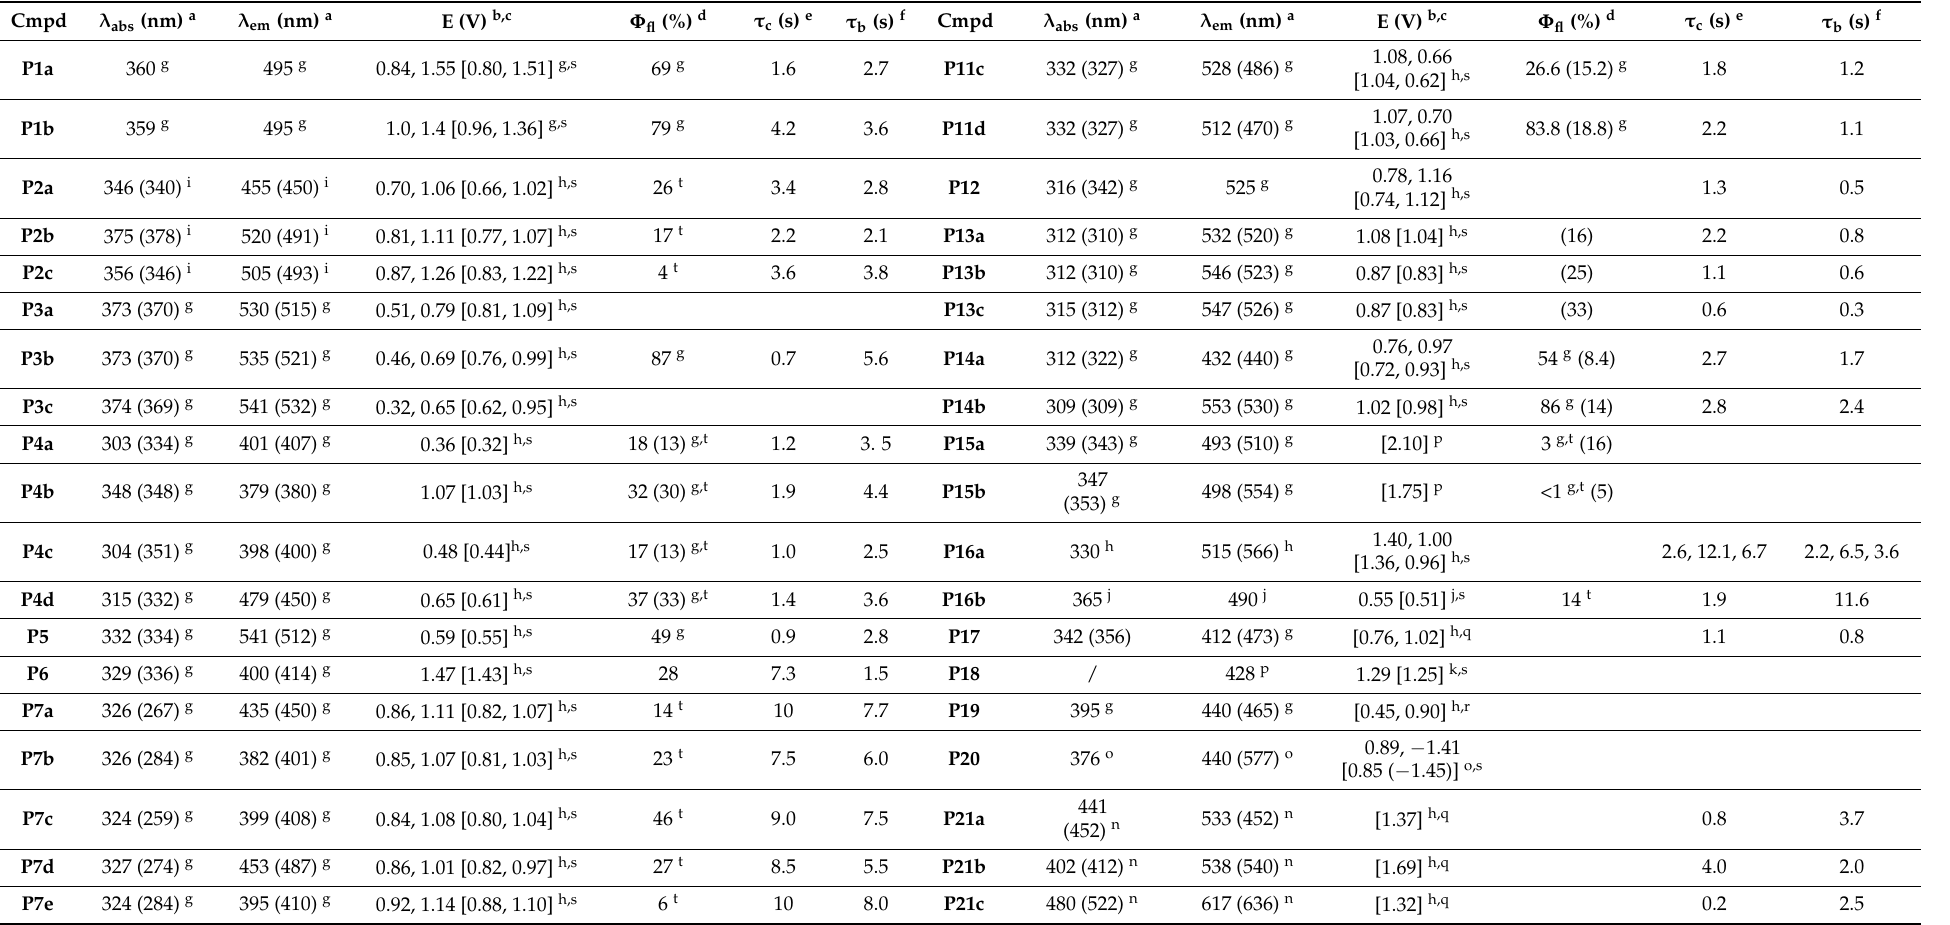
Table 2. Collective spectroscopic and electrochemical data of electrofluorochromic